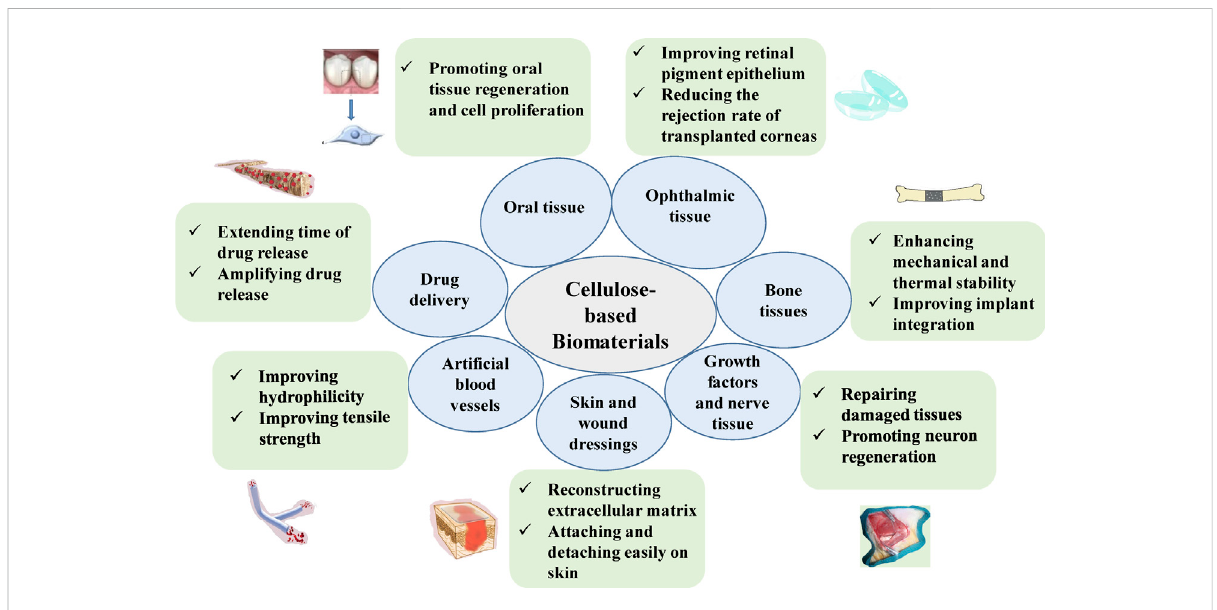
FIGURE 2 Biomedical applications and advantages of cellulose-based